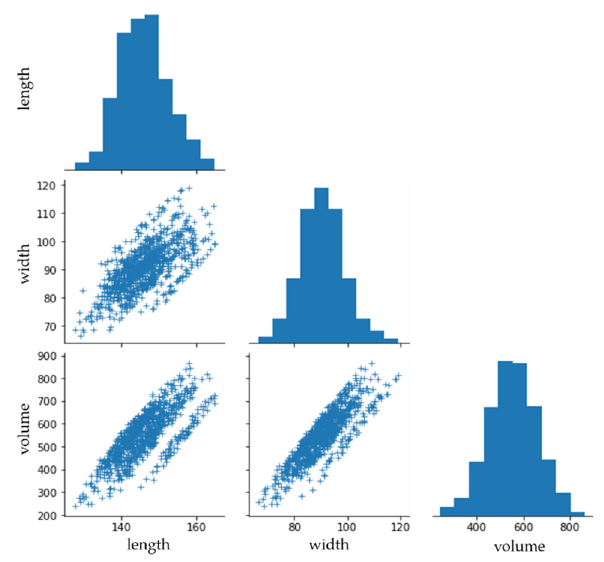
Figure 13. The linear relationship between length, width, and volume. Table 2. The accuracy of estimated features.